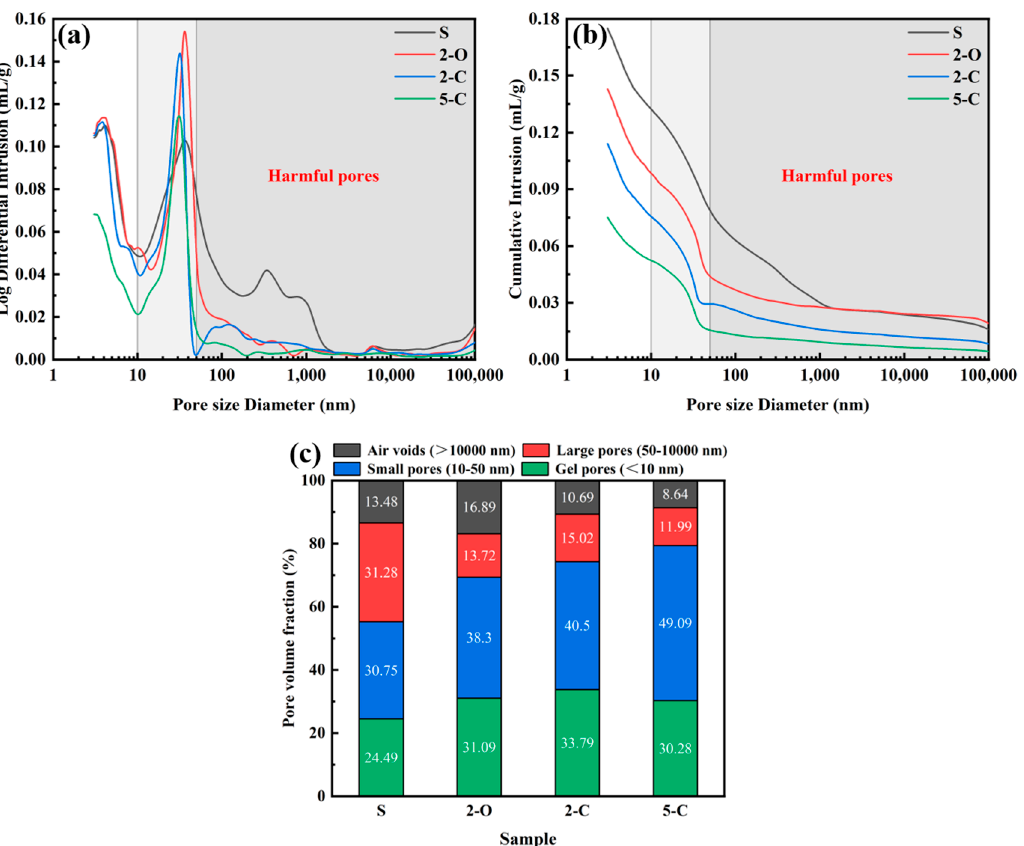
Figure 15. Pore structure characteristics of specimens under sulfate attack.